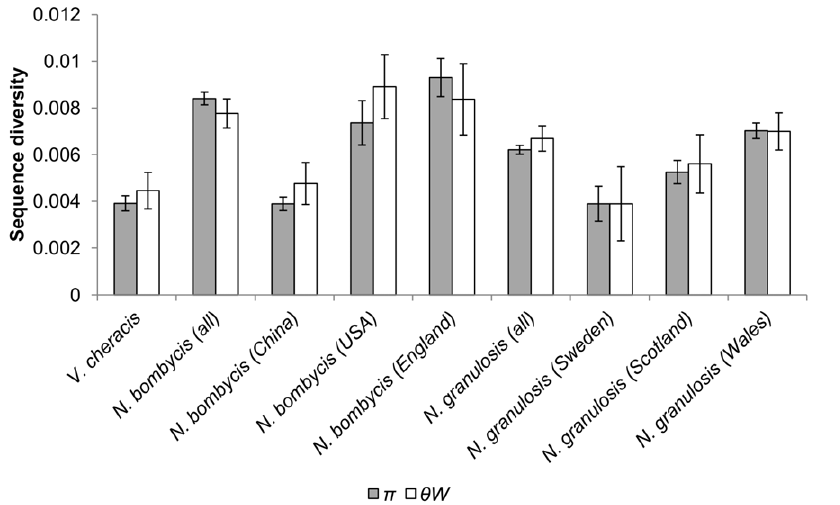
Figure 4. Nucleotide diversity of the IGS and flanking 16S and 5.8S rDNA regions of N.bombycis , N.granulosis and V.cheracis isolates. Nucleotide diversity is calculated as the average heterozygosity per site ( p ) and the average number of nucleotide differences per site ( h W ). Error bars show the standard error for each isolate.